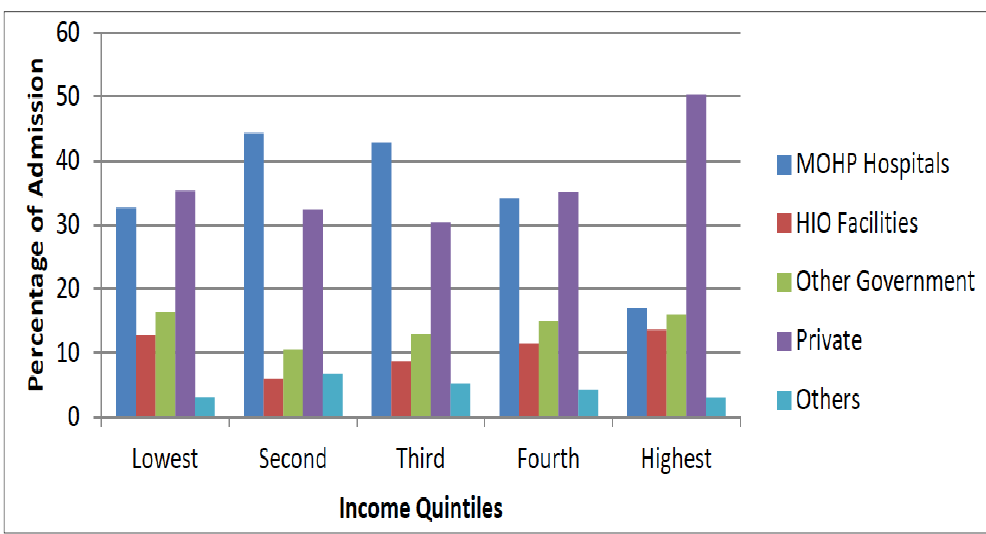
Figure 3. Inpatient care provider by income quintile. Source: Egypt National Health Accounts